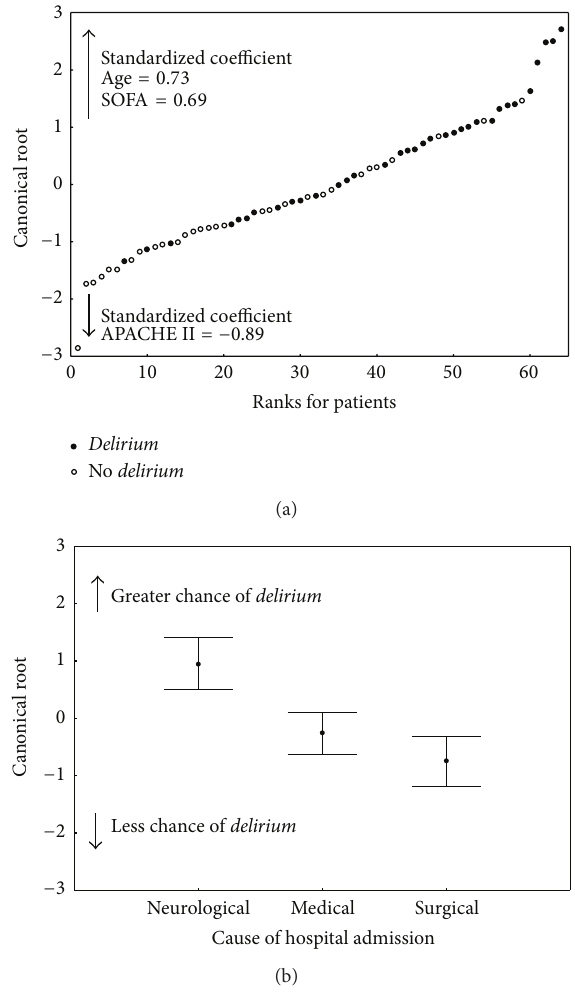
Figure 4: Multivariable analysis of delirium predictors. (a) Values of canonical root by linear combination of age, SOFA score, and APACHE II score according to the level obtained by each patient and categorised in accordance with the occurrence or absence of delirium . (b) Mean values ± 95% confidence interval for the canonical root of each speciality category. SOFA: sequential organ failure assessment; APACHE II: acute physiology and chronic health